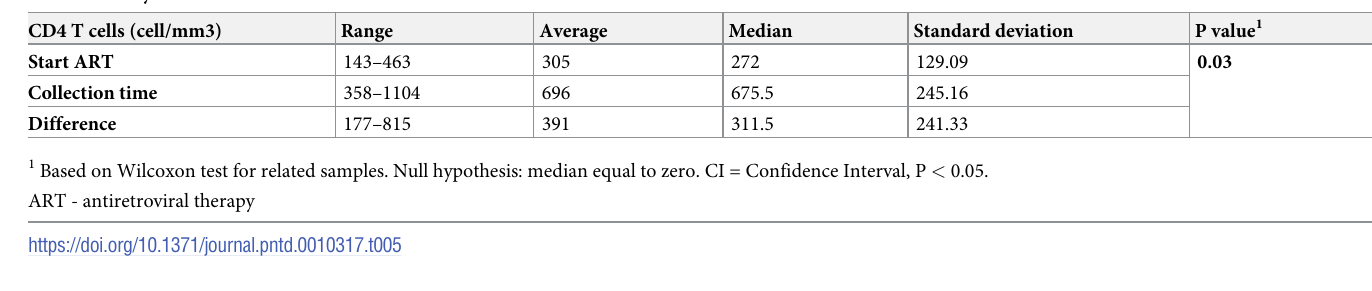
the parasite belonging to the DTU TcII (Table 1). In 2003, at the beginning of antiretroviral